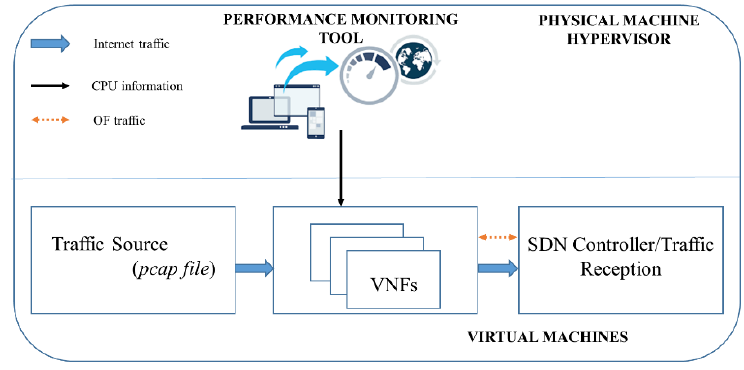
Figure 6. Configuration setup for collecting the data set.